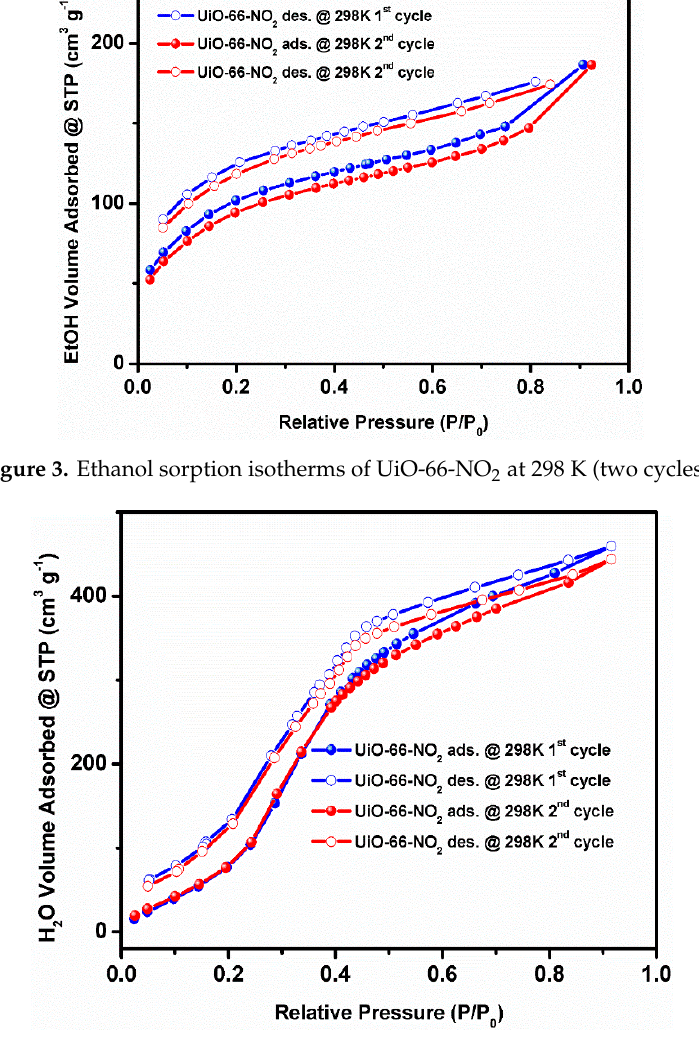
Figure 4. Water sorption isotherms of UiO-66-NO 2 at 298 K (two cycles).